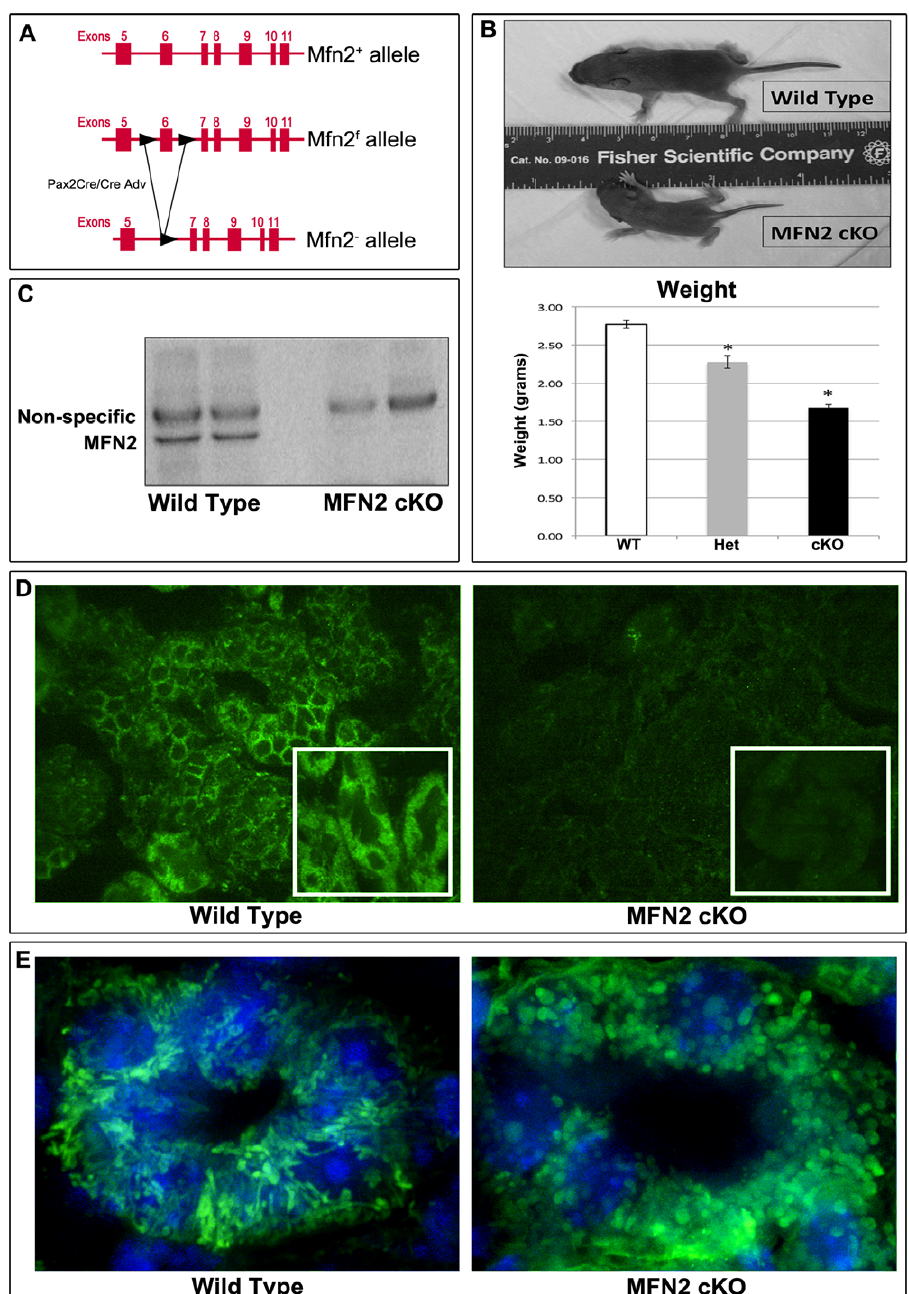
Figure 1. Generation and phenotype of MFN2 cKO mice. ( A ) Two LoxP sites flank exon 6 in the region coding for the canonical G-1 GTPase motif are shown. Cre recombinase excises exon 6 that causes a frame shift which precludes functional protein production. For in vivo experiments, animals were crossed with Pax2-Cre expressing mice creating MFN2 conditional knockouts (MFN2 cKO). ( B ) MFN2 cKO mice are significantly smaller than wild type littermate controls. * P , 0.05 vs. WW ; n $ 8 per group. ( C ) MFN2 content in wild type and MFN2 cKO kidney homogenates. The MFN2- specific band is absent in homogenates harvested from MFN2 cKO mice. ( D ) MFN2 immunofluorescence staining in littermate wild type and MFN2 knockout kidney sections. MFN2 staining is absent in MFN2 cKO animals; 200 6 magnification ( inset : 400 6 magnification). ( E ) Immunostaining for F 1 F 0 -ATPase, an intrinsic mitochondrial membrane protein, in wild type and MFN2 cKO kidney; mitochondria( white arrows ) in tubule epithelia of MFN2 cKO mice appear fragmented and punctate compared to wild type littermates. Hoechst dye was used to stain tubule cell nuclei.